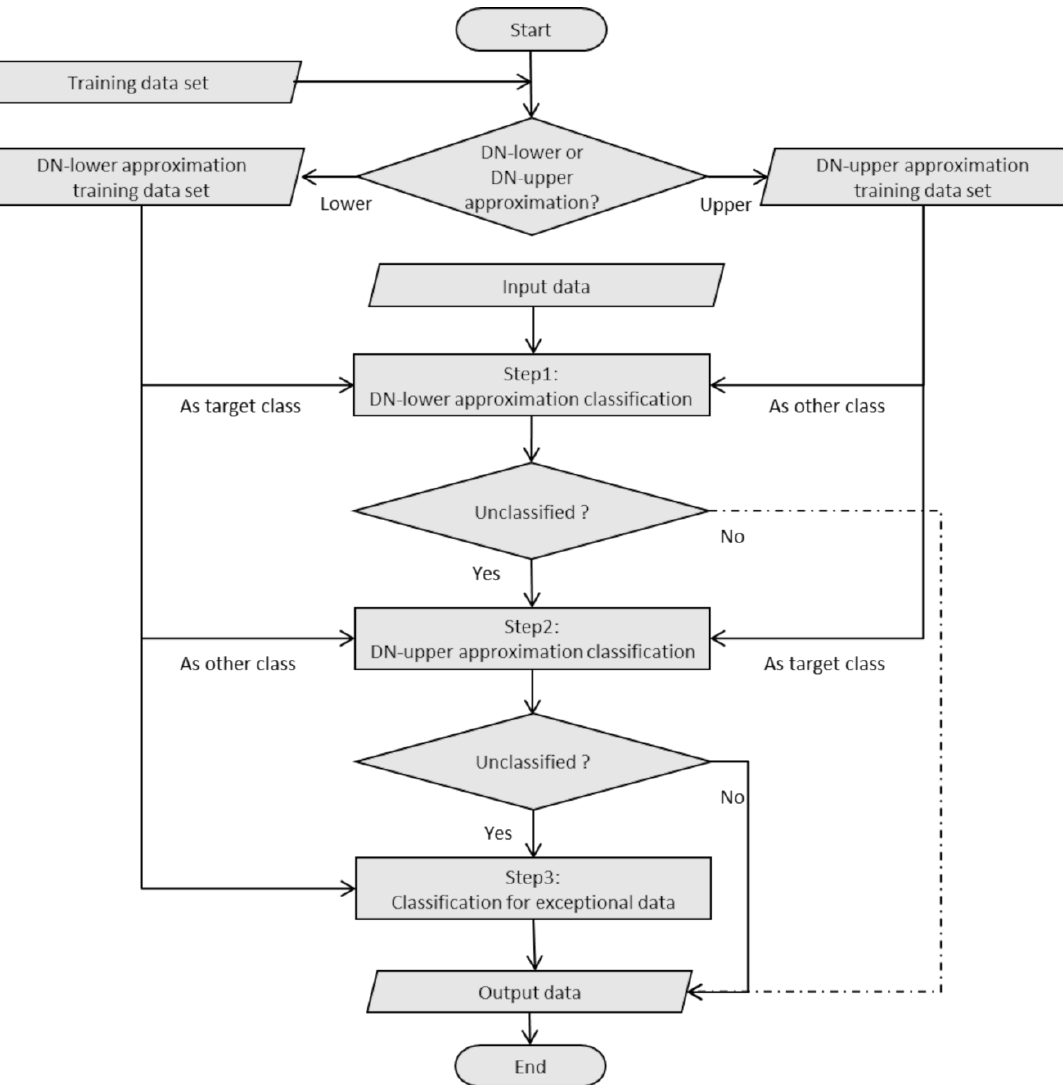
Figure 3. Flow of DNRS model.